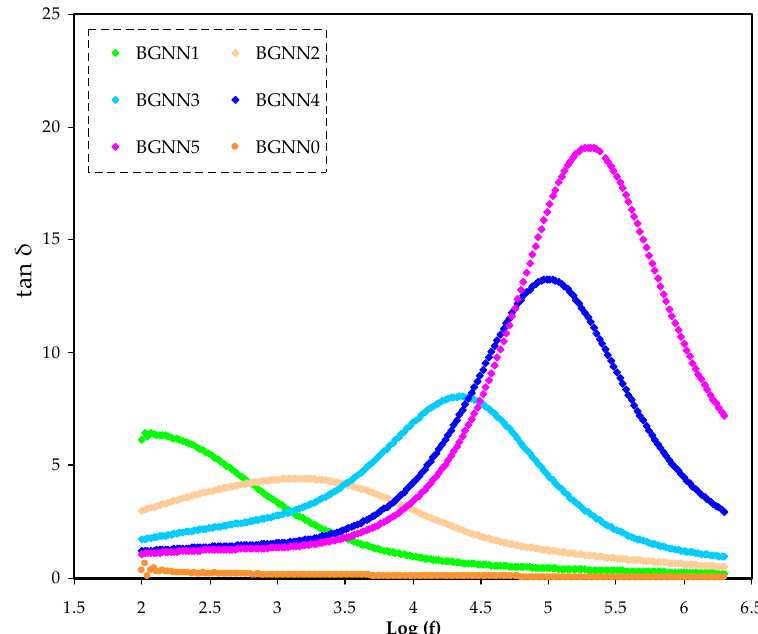
Figure 6. Loss tangent (tan δ ) spectra for the NBG systems.